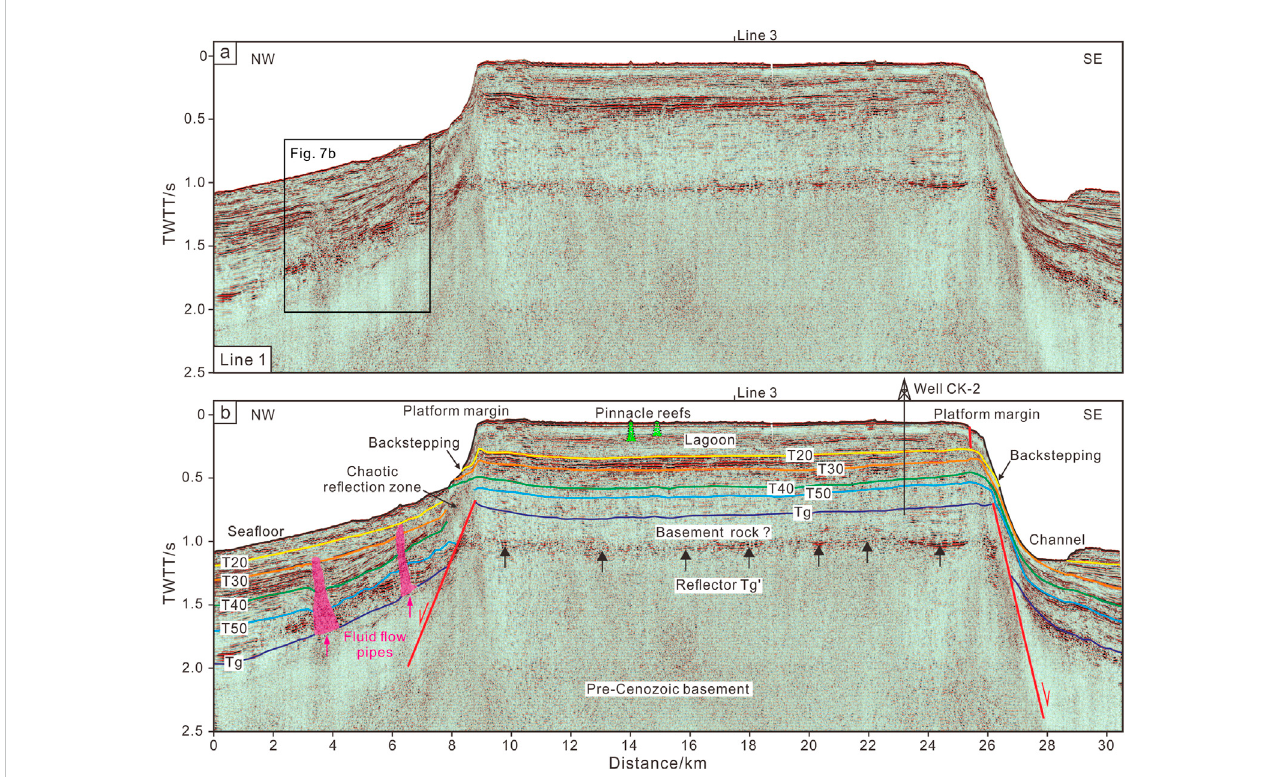
FIGURE 3 Line 1 multi-channel seismic re fl ection pro fi le (A) and its interpretation (B) . See Figure 1 for location. Red lines represent normal faults. Green lines represent pinnacle reefs. Carmine areas mark the fl uid fl ows pipes and arrows show their migrated directions. Black arrows mark the location of re fl ector Tg ’ . T20, T30, T40, T50, Tg, Tg ’ : seismic re fl ectors. TWTT: two-way travel